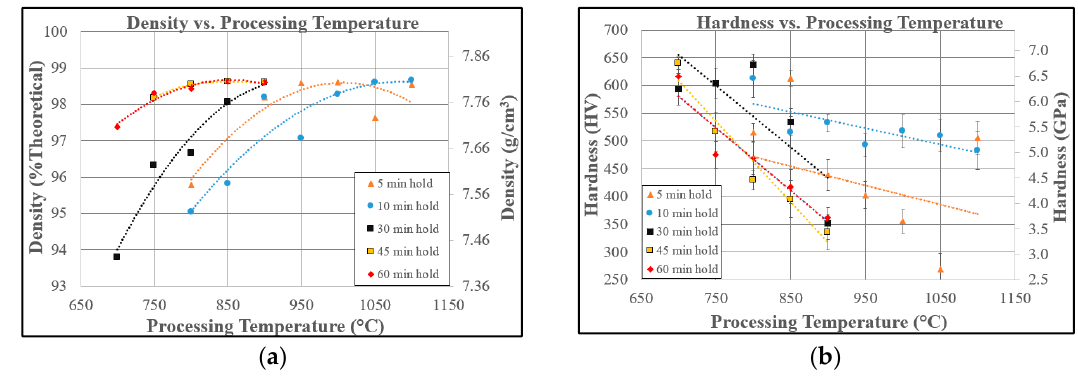
Figure 1. Experimentally measured density ( a ) and hardness ( b ) values as a function of processing temperature and hold time.